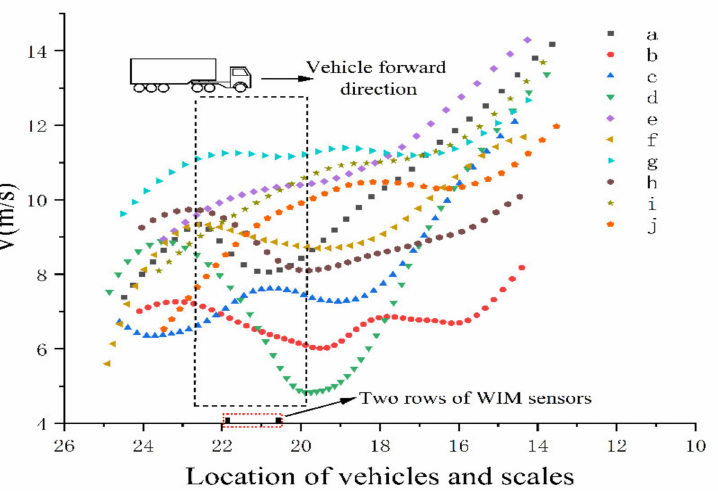
Figure 17. Comparison chart of different driving states of the truck for the validation